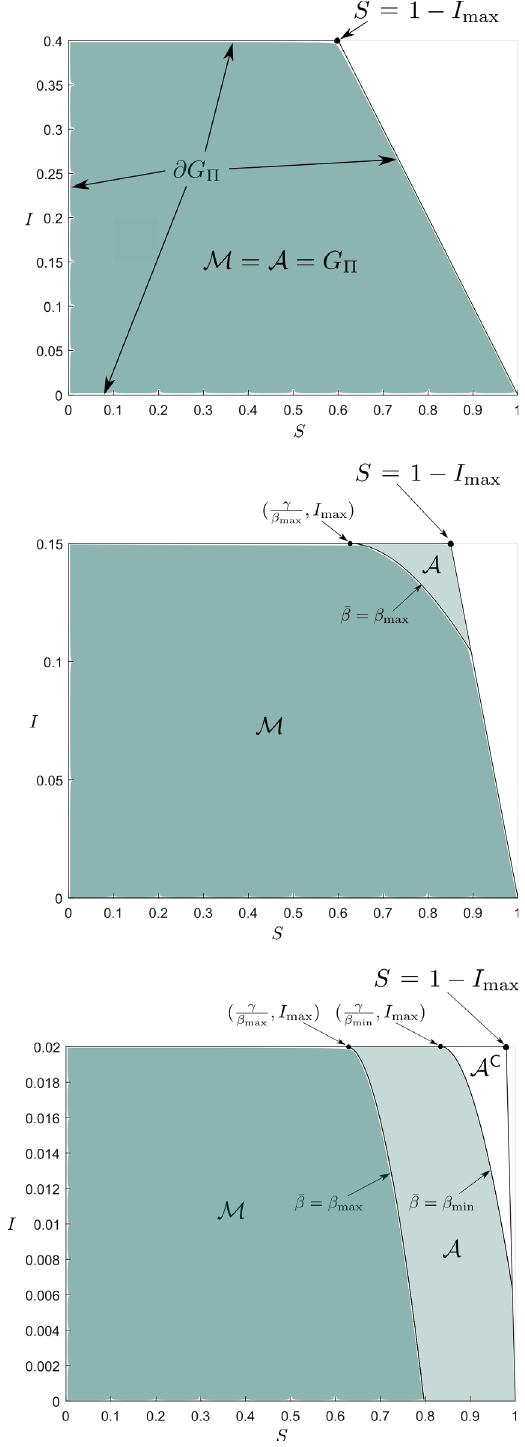
Fig 1. Sets for perfect SIR model example. Projections of the admissible and MRPI sets onto the S − I axes are shown. If the infection cap is large enough the entire constrained state space G P is robustly invariant (top figure), otherwise the sets are subsets of G P